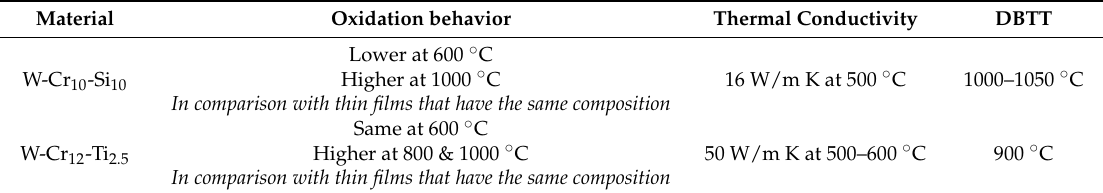
Table 2. Characteristics of two W based alloys